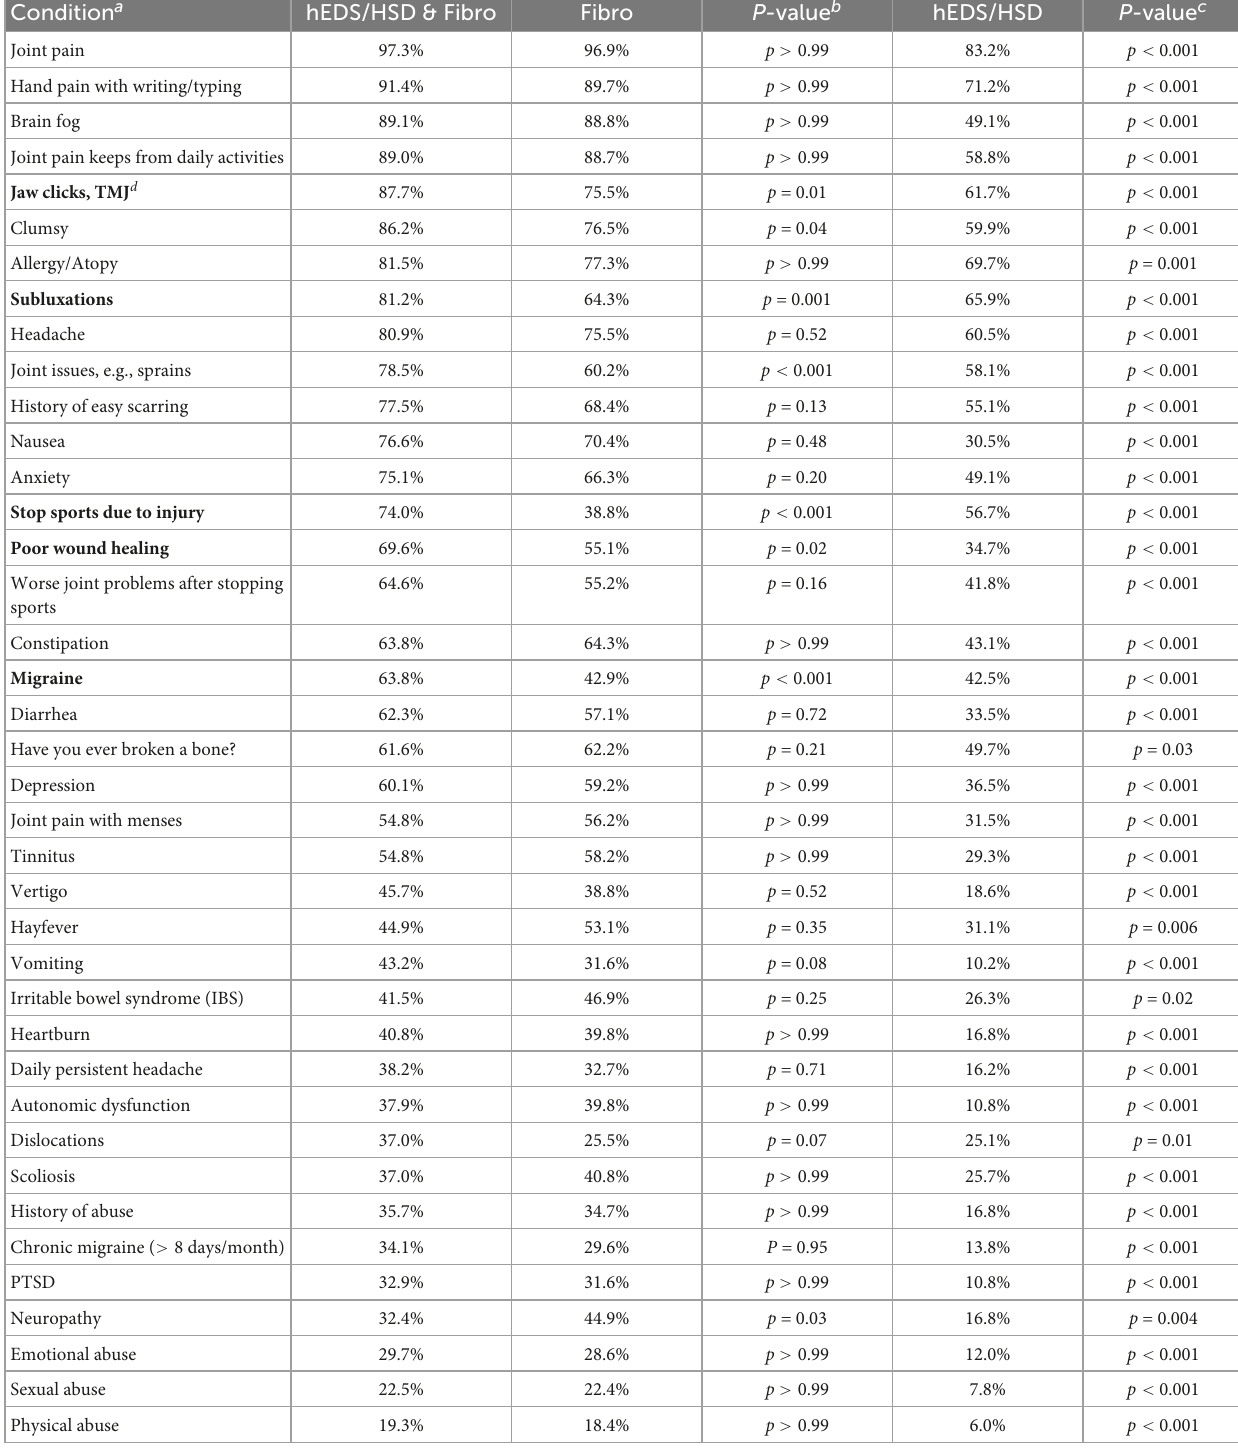
TABLE 7 Comparison of hEDS/HSD&Fibro ( n = 414) to Fibro ( n = 98) or hEDS/HSD ( n = 167) in men and women. Condition a